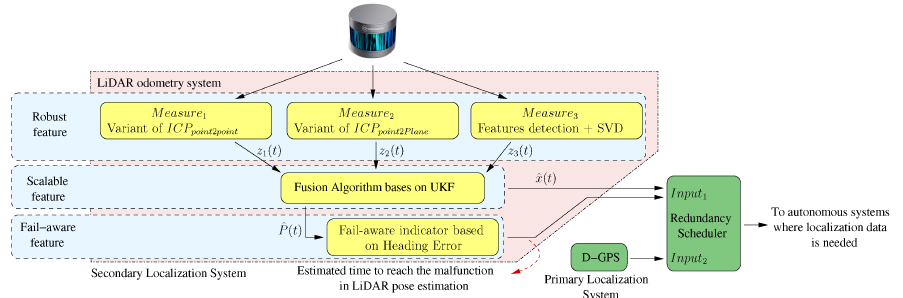
Figure 20. General diagram. The developed blocks are represented in yellow. The horizontal blue strips represent the main features of the odometry system. A framework where the LiDAR odometry system can be integrated within the autonomous driving cars topic is depicted with green blocks, such as a secondary localisation system (image obtained from